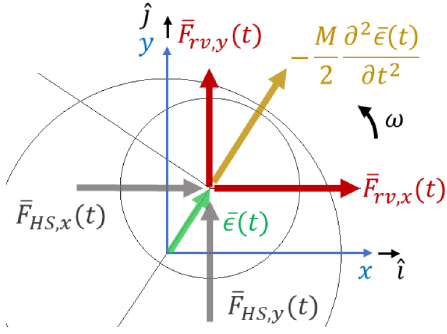
Fig. 5. Free body diagram of the